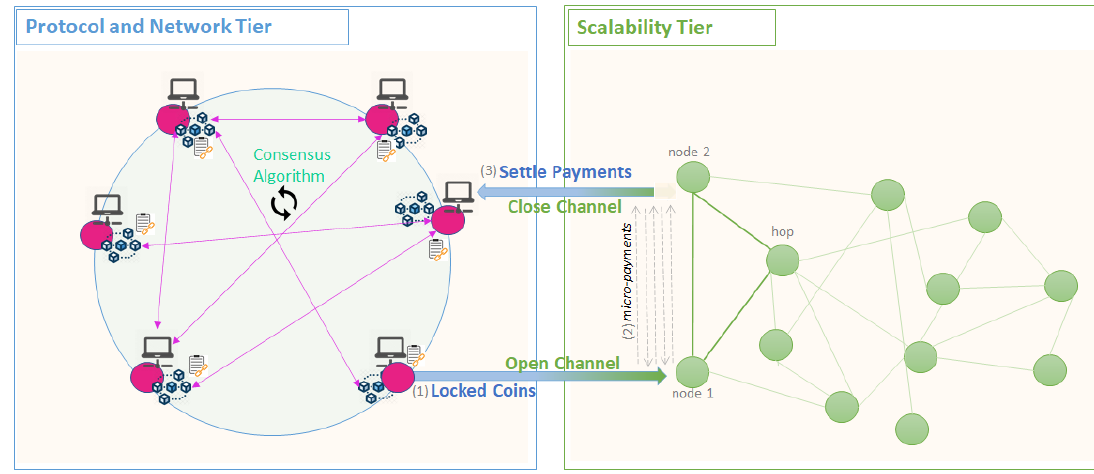
Figure 5. Scalability Tier—Payment Channels Mechanism.